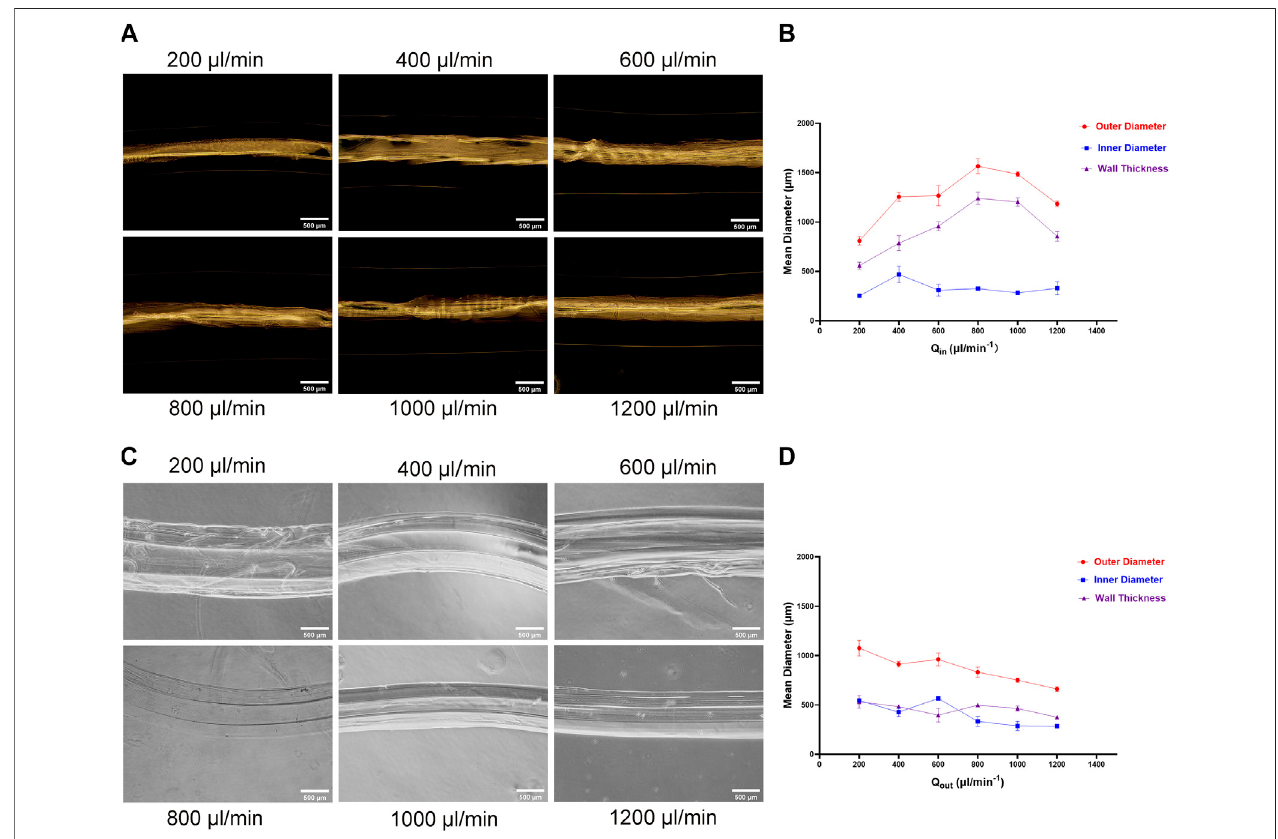
FIGURE 2 | In fl uence of Outer and Inner Liquid Flow Rate on Microtubes (A) The photograph of the prepared hydrogel microtubes: when the fl ow rate of the outer liquid was consistent with 1,000 μ L/min, the fl ow rate of the inner liquid was 200 μ L/min, 400 μ L/min, 600 μ L/min, 800 μ L/min, 1,000 μ L/min, 1,200 μ L/min, respectively,thescaleis500 μ m (B) Thelinegraphshowstherelationshipbetweentheinnerliquid fl owrateandthemicrotubestructure (C) Photographoftheprepared hydrogel microtubes: the inner liquid fl ow rate was consistent with 400 μ L/min, and the outer liquid fl ow rate was 200 μ L/min, 400 μ L/min, 600 μ L/min, 800 μ L/ min, 1,000 μ L/min, and 1,200 μ L/min, respectively, the scale is 500 μ m (D) The line graph shows the relationship between the outer liquid fl ow rate and the microtube structure.